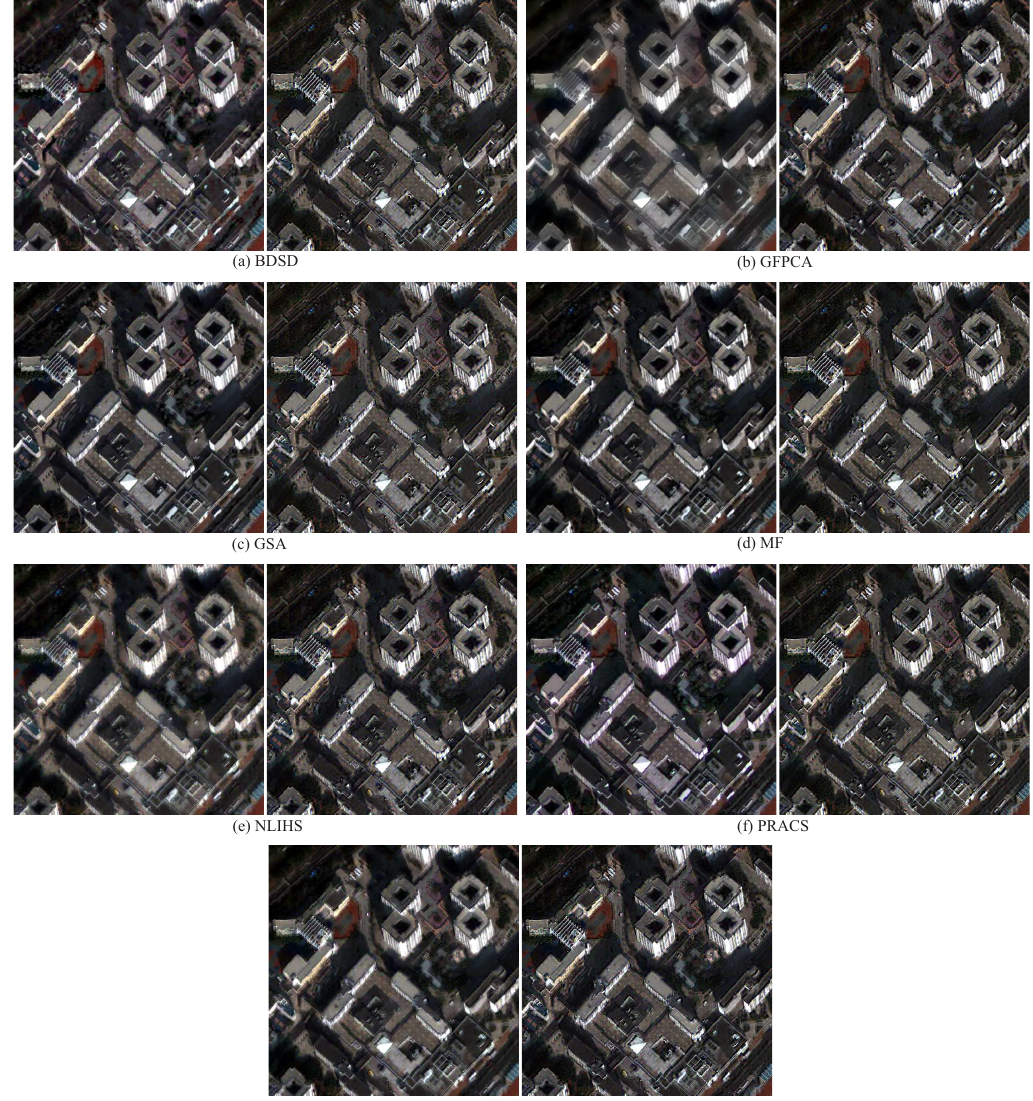
Figure 2. Visual comparison of the fused images obtained by eight methods with and without the proposed EBP as postprocessing on the QuickBird dataset, ( a ) BDSD; ( b ) GFPCA; ( c ) GSA; ( d ) MF; ( e ) NLIHS; ( f ) PRACS; ( g ) SFIM. In contrast, the results with EBP postprocessing (on the right side of each subfigure) have more spatial details and more pleasant colors than those of without EBP (on the left side of each subfigure). Best zoomed in on screen for visual comparison